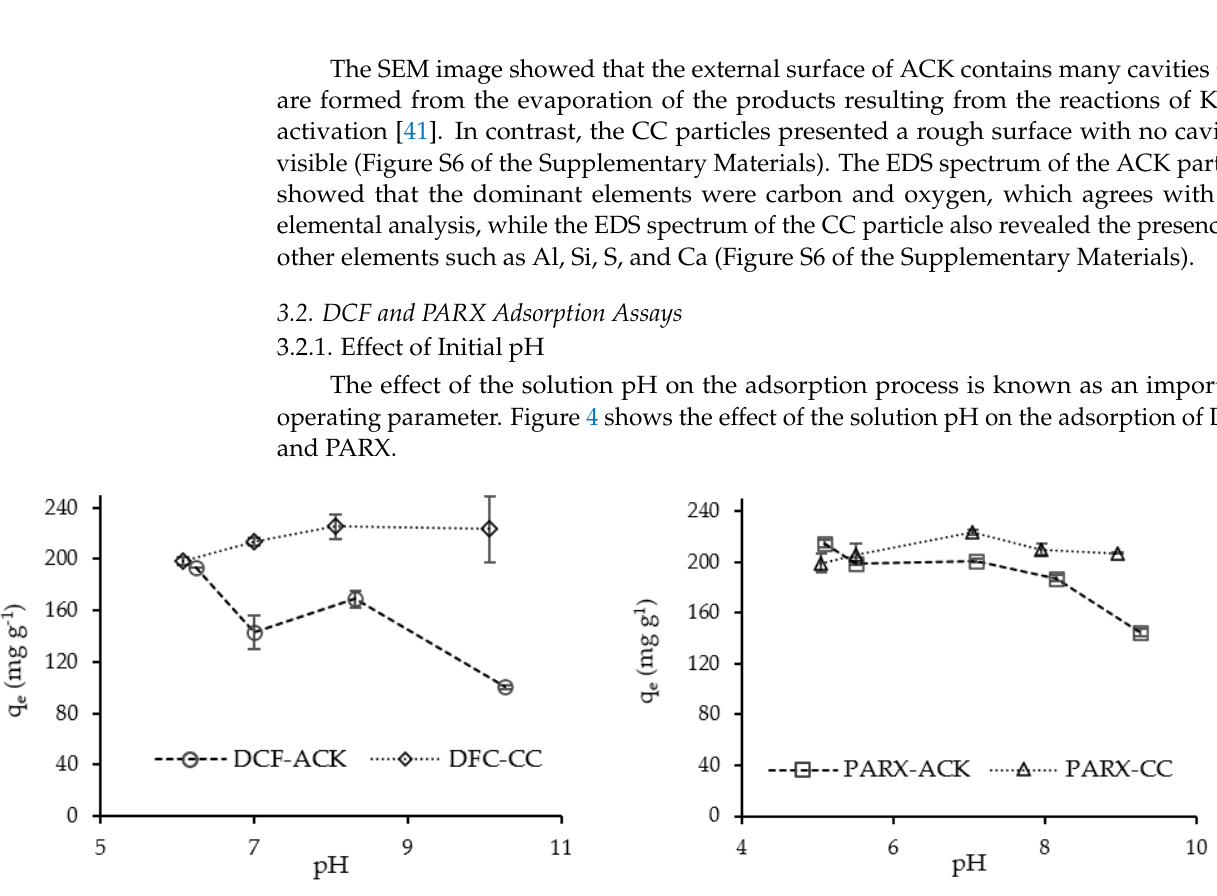
Figure 4. Effect of solution pH on the uptake capacity of DCF and PARX for ACK and CC carbons. (Adsorbent mass = 10 mg; DCF and PARX initial concentration = 100 mg L − 1 ; solution volume = 25 mL; contact time = 24 h).